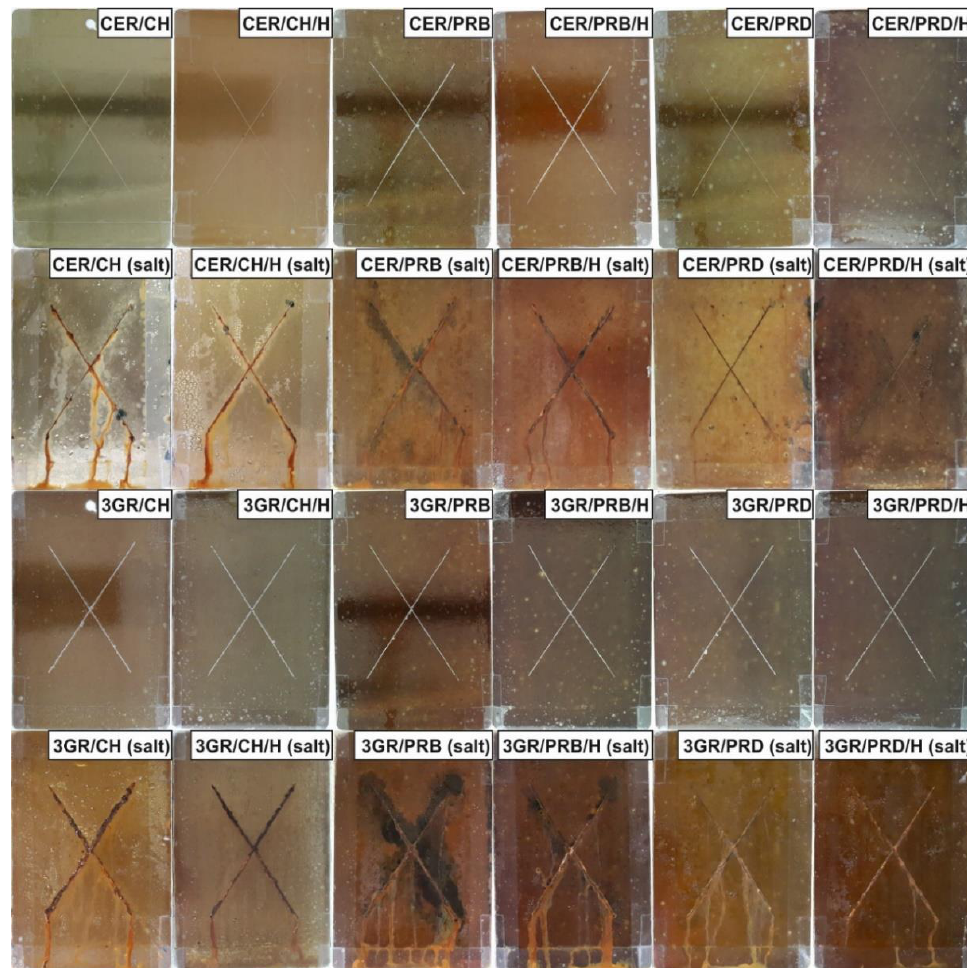
Figure 6. Prepared coatings and reference samples before and after 1000 h of salt spray test.